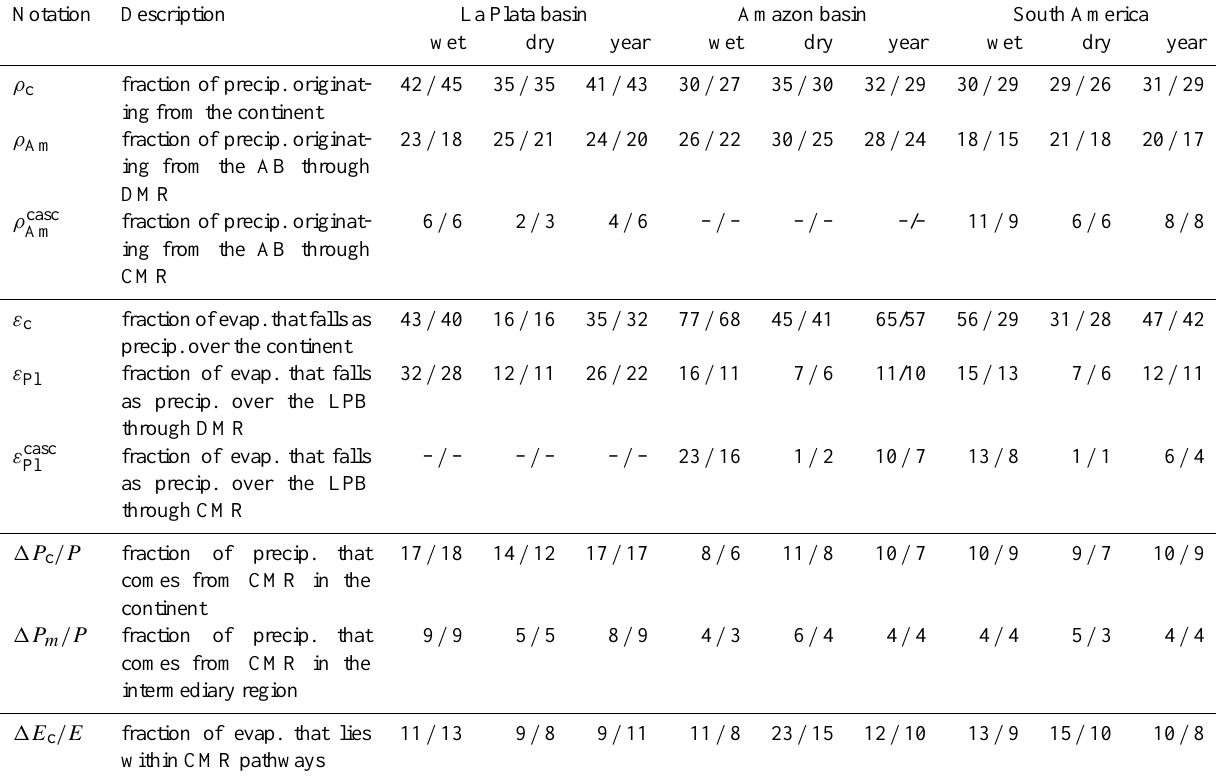
Table 3. Importance of direct moisture recycling (DMR) and cascading moisture recycling (CMR) for the total precipitation (precip.) and evapotranspiration (evap.) averaged for the La Plata basin (LPB), the Amazon basin (AB) and for the South American continent during the wet season (DJFM), the dry season (JJAS) and all year round calculated for the input MOD / LFE (in